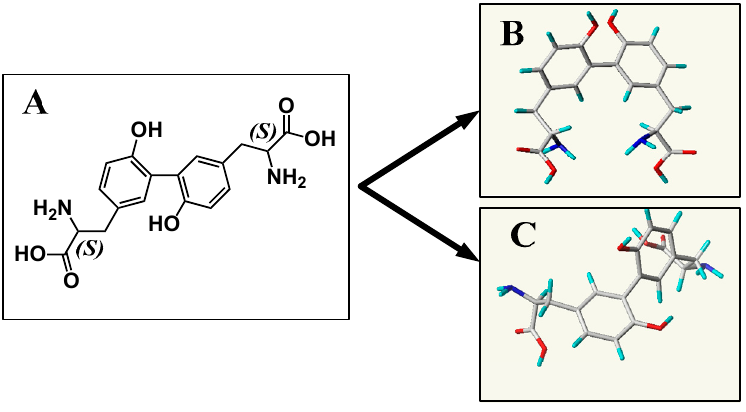
Figure 11. ( A ) Chemical structure of dityrosine. ( B ) Three-dimensional structure of CDT. ( C ) Three-dimensional structure of TDT.